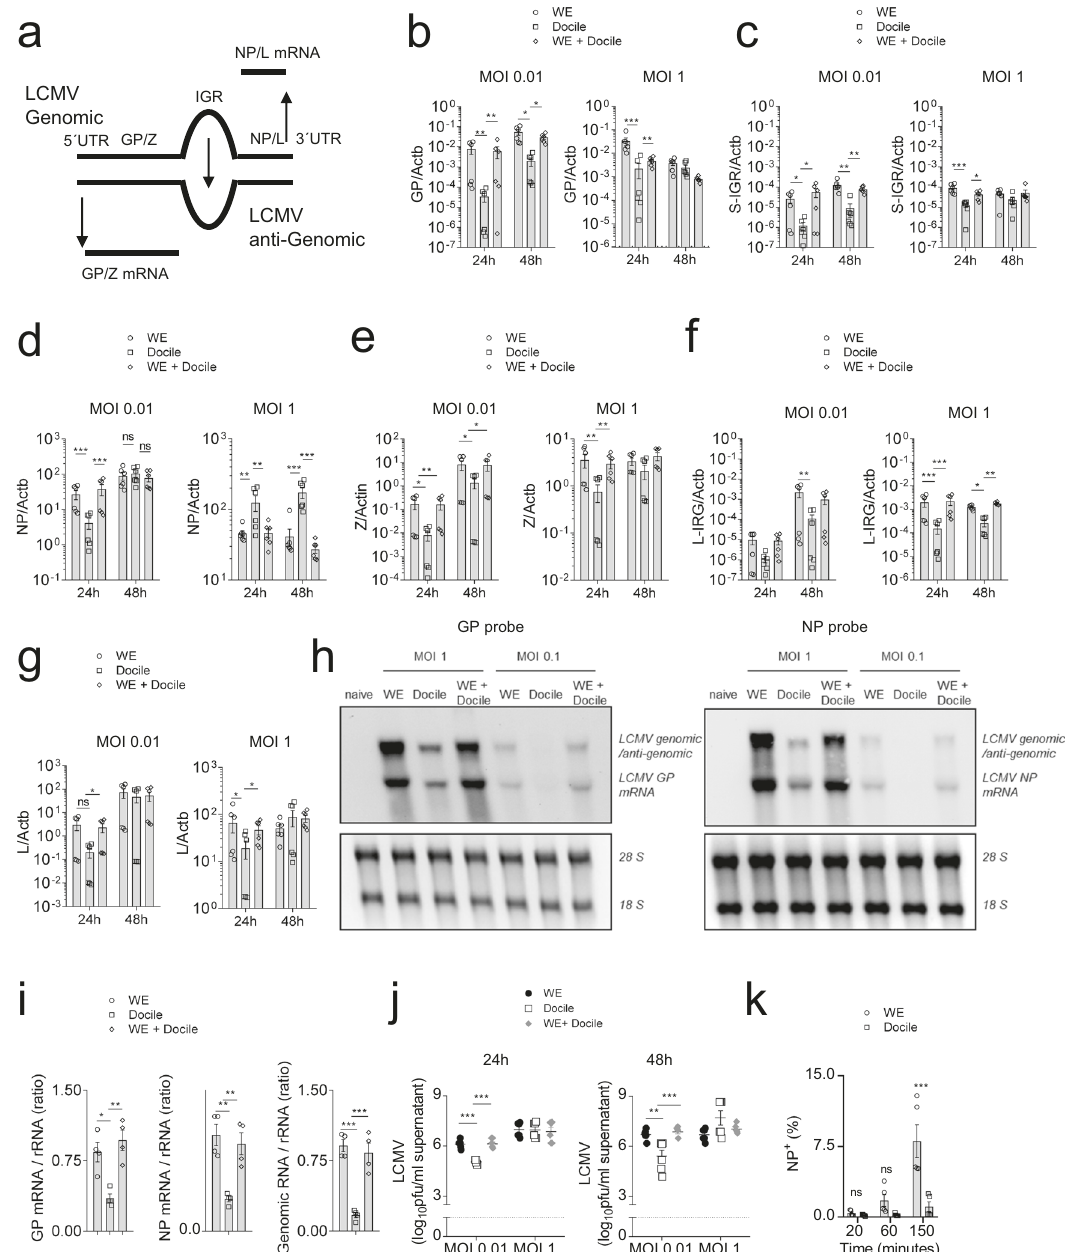
Fig. 5 LCMV-Docile exhibited slow propagation compared to the LCMV-WE strain. a A schematic of LCMV-S-segment replication is shown. b – g BHK-21 cells were infected with LCMV-WE, LCMV-Docile, or both at the indicted MOI ’ s. At 24 h and 48 h post-infection, BHK-21 cellular RNA was isolated and b GP RNA, c S-IGR RNA, d NP RNA, e Z RNA, f L-IRG RNA, and g L RNA were assessed by RT-PCR ( n = 6). h 24 h post-infection, BHK-21 cellular RNA was analysed by northern blot using GP or NP speci fi c probes (one of n = 4 representative blot was shown, uncropped scan blots in Supplementary Fig. 11). i Ratio of GP mRNA/ribosomal RNA, NP mRNA/ ribosomal RNA and genomic viral RNA/ribosomal RNA were quanti fi ed ( n = 4). j Virus titers were determined from LCMV infected BMDC supernatant at 24 h and 48 h post-infection ( n = 6). k BHK-21 cells were infected with LCMV-WE or LCMV-Docile at MOI 0.5, and, at the indicated timepoints post-infection, monensin was added. Sixteen hours later LCMV infected cells were quanti fi ed by anti-LCMV- NP staining ( n = 5, gating strategy is shown in Supplementary Fig. 12). (Error bars show SEM, * p < 0.05, ** p < 0.01, *** p < 0.001, and ns indicates statistically not signi fi cant between the indicated LCMV titers were detected in the supernatant of LCMV-WE molecules when compared to the nontreated group (Fig. 6e). infected cells in comparison to LCMV Docile infected cells (Fig. 6b). Expression of co-stimulatory molecules in BMDCs following LCMV infection was dependent on IFNAR signaling (Fig. 6c). When rIFN- α was added to LCMV infected BMDCs, virus replication was inhibited in all groups (Fig. 6d), and LCMV Docile infected BMDCs upregulated co-stimulatory